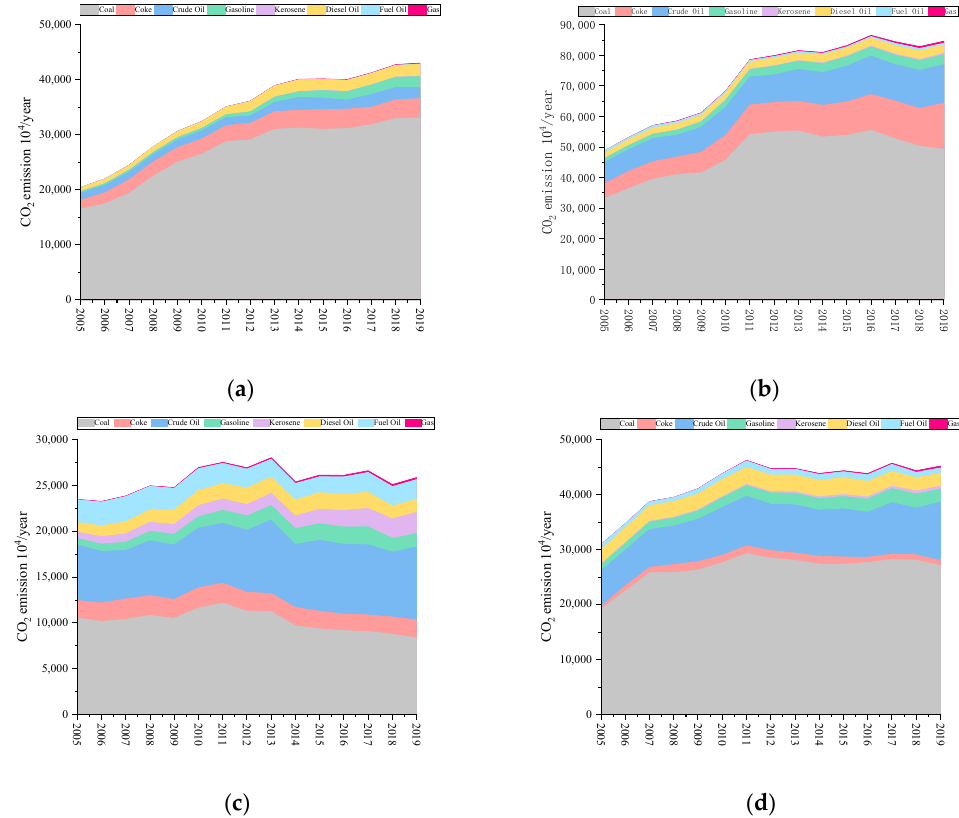
Figure 2. Energy carbon emission structure of each province from 2005 to 2019: ( a ) Anhui; ( b ) Jiangsu; ( c ) Shanghai; ( d ) Zhejiang.